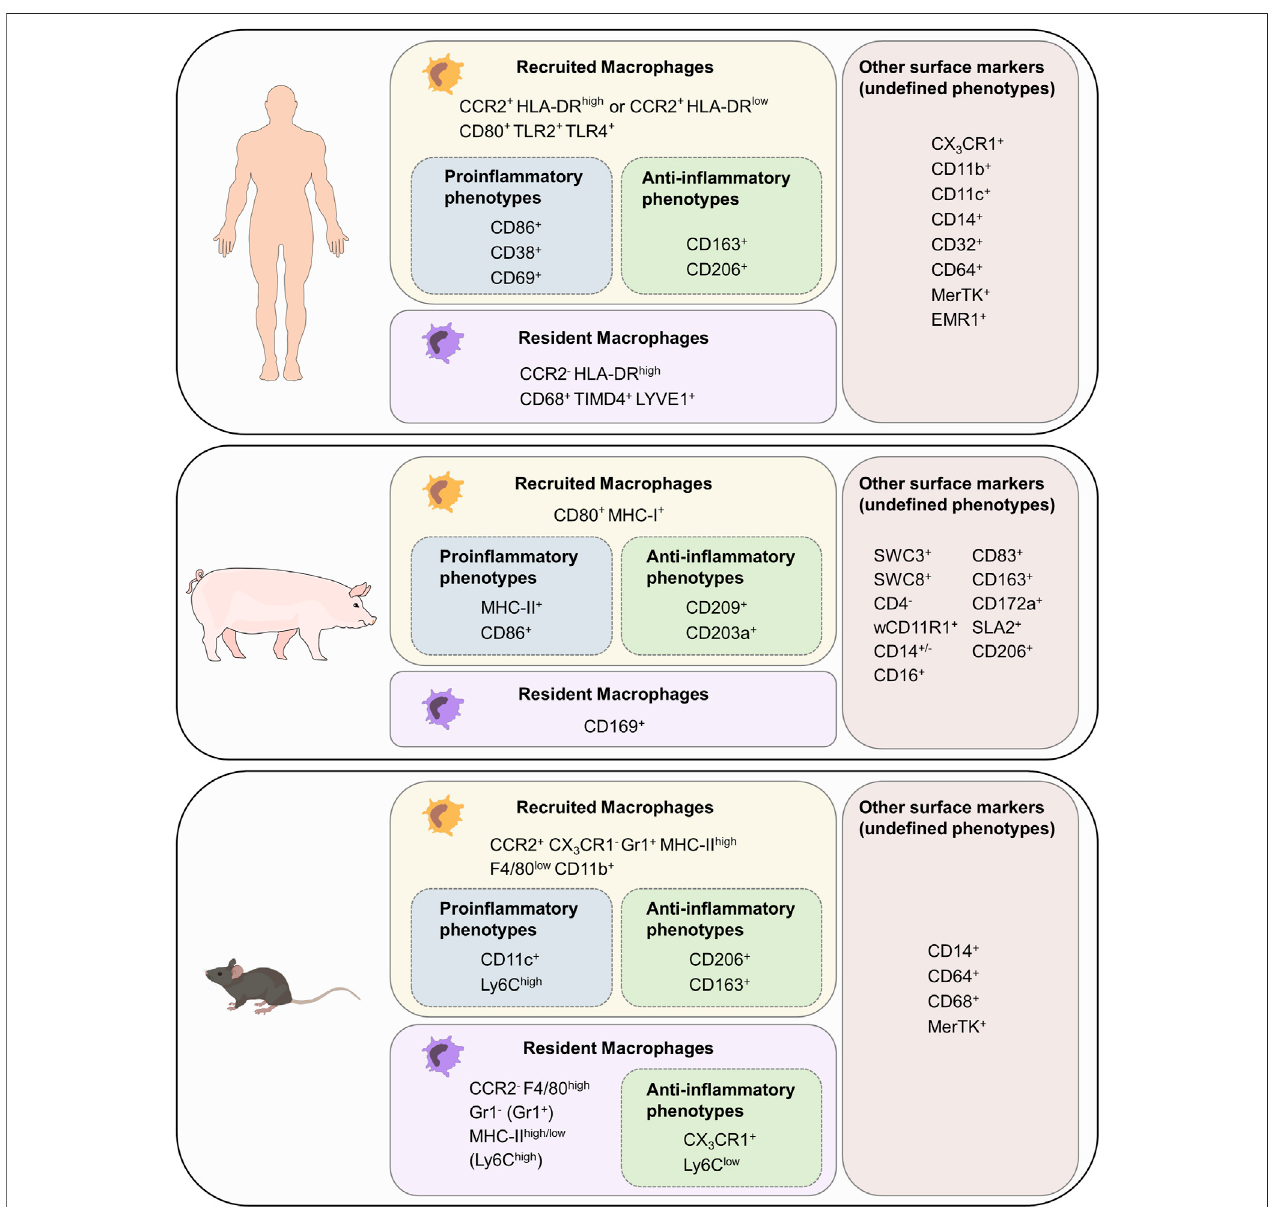
FIGURE3| Cardiacmacrophagesurfacemarkersinmouse,pigandhuman.Listofsurfacemarkersforrecruitedandresidentmacrophagesaswellasmarkersfor proin fl ammatory and anti-in fl ammatory phenotypes. Surface markers with unknown association to function have been grouped as “ other surface markers (unde fi ned phenotypes). F4/80 in mouse is the homolog for EMR in